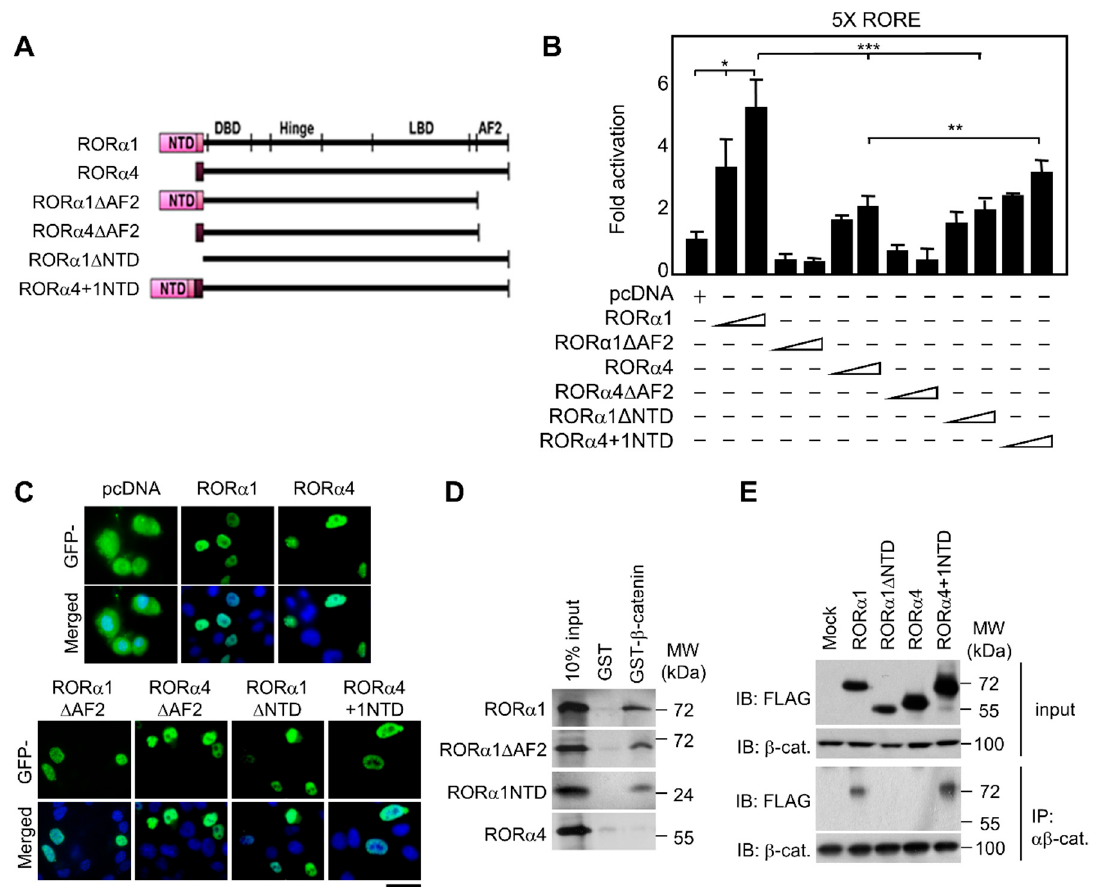
Figure 1. N-terminal domain of ROR α 1 is sufficient for regulating target genes. ( A ) Illustration of the structure of ROR α 1, ROR α 4, ROR α 1 ∆ AF2, ROR α 4 ∆ AF2, ROR α 1 ∆ NTD, and ROR α 4 + 1NTD. ( B ) Luciferase assay was conducted using FLAG-pcDNA, ROR α 1, ROR α 4, ROR α 1 ∆ AF2, ROR α 4 ∆ AF2, ROR α 1 ∆ NTD, and ROR α 4 + 1NTD on a 5 × RORE luciferase reporter. Values are expressed as mean ± SD for three independent experiments and normalized by β -galactosidase expression (mean ± SD, n = 3). The p value was calculated by a t -test (* p < 0.05, ** p < 0.01) or one-way ANOVA (*** p < 0.001). ( C ) Subcellular localization of GFP-pcDNA, GFP-ROR α 1, GFP-ROR α 4, GFP-ROR α 1 ∆ AF2, GFP-ROR α 4 ∆ AF2, GFP-ROR α 1 ∆ NTD, and GFP-ROR α 4 + 1NTD constructs (green). Nuclei were visualized by DAPI staining (blue). Scale bar, 20 µ m. ( D ) Interaction of each in vitro transcribed and translated ROR α 1, ROR α 1 ∆ AF2, ROR α 1NTD and ROR α 4 constructs with glutathione S-transferase (GST) or GST fusion of β -catenin was assessed by GST pulldown assay. ( E ) Coimmunoprecipitation of endogenous β -catenin with each FLAG-tagged ROR α construct.